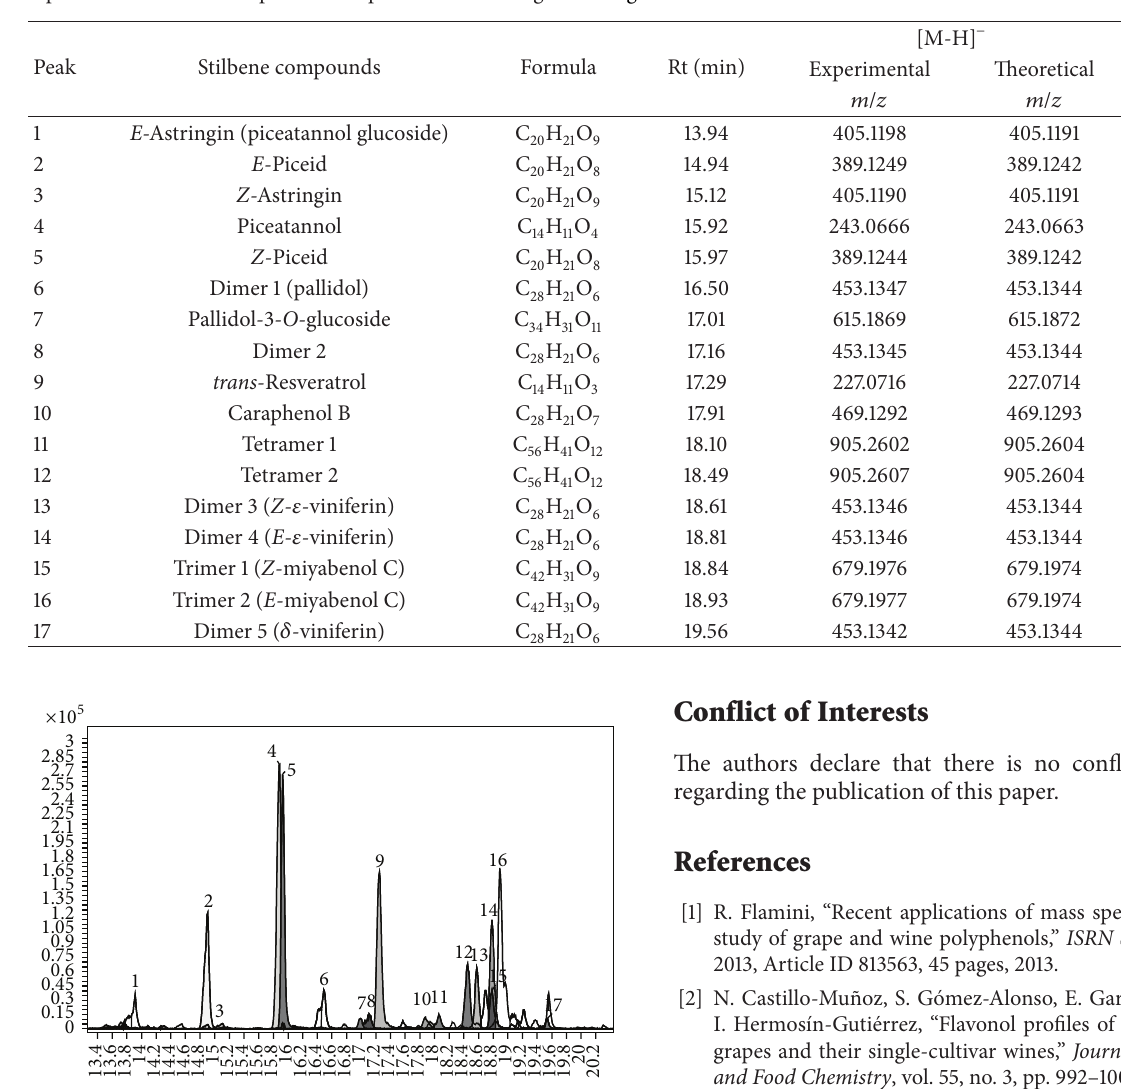
Table 3: Stilbene [ M-H ] − ions identified in Primitivo grape extract. Identification scores calculated with respect to the theoretical mass are reported. Numbers correspond to the peaks of chromatogram in Figure 6.